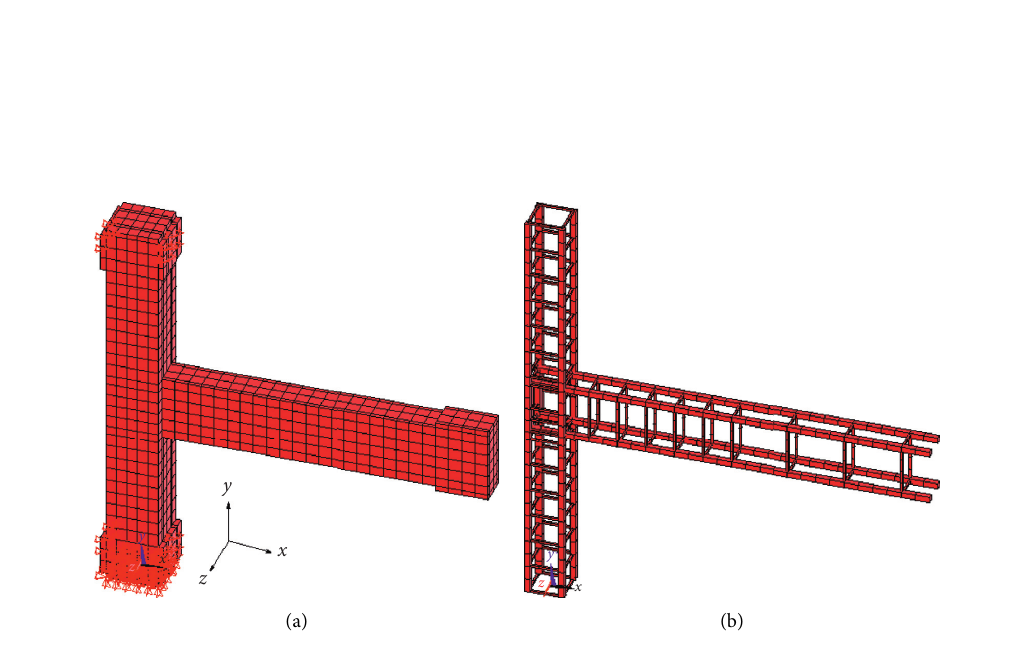
Figure 3: Finite element model of frame exterior